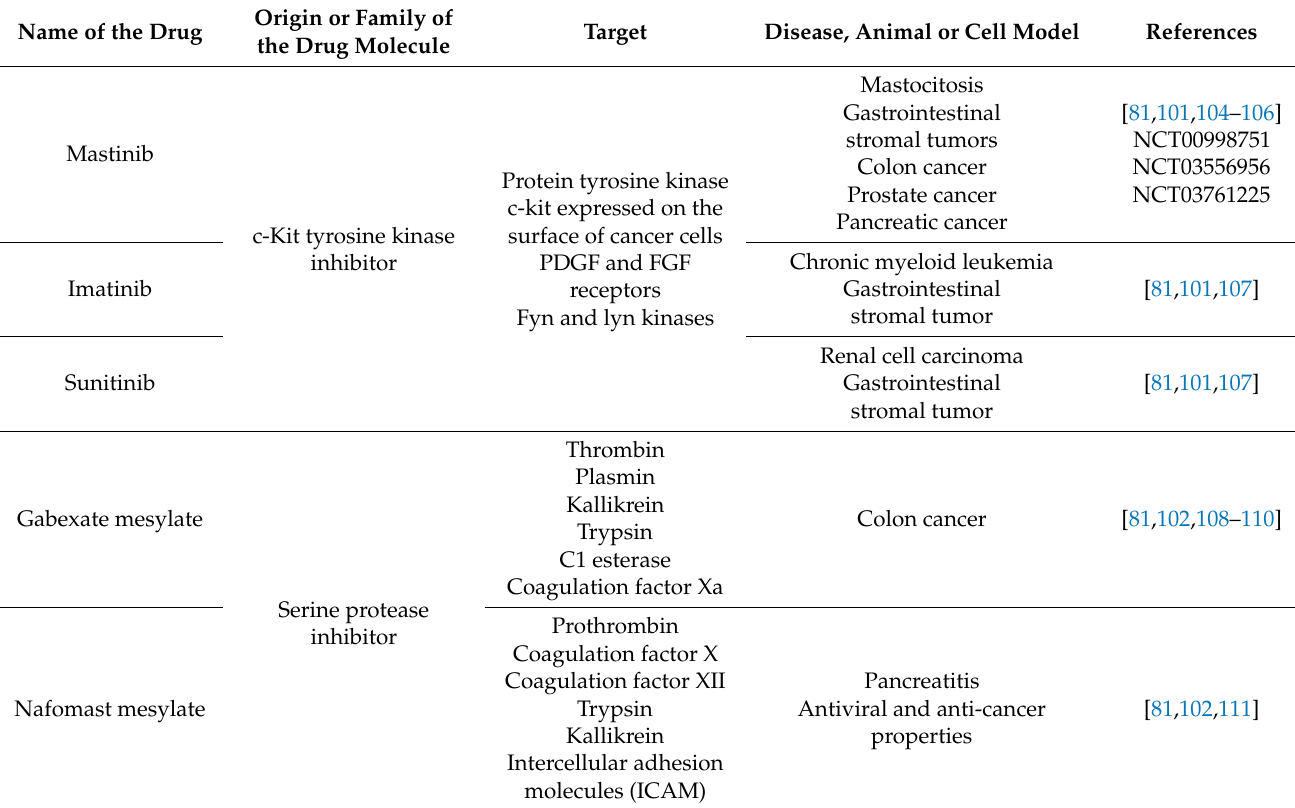
Table 3. Mast cell-targeted strategies in cancer